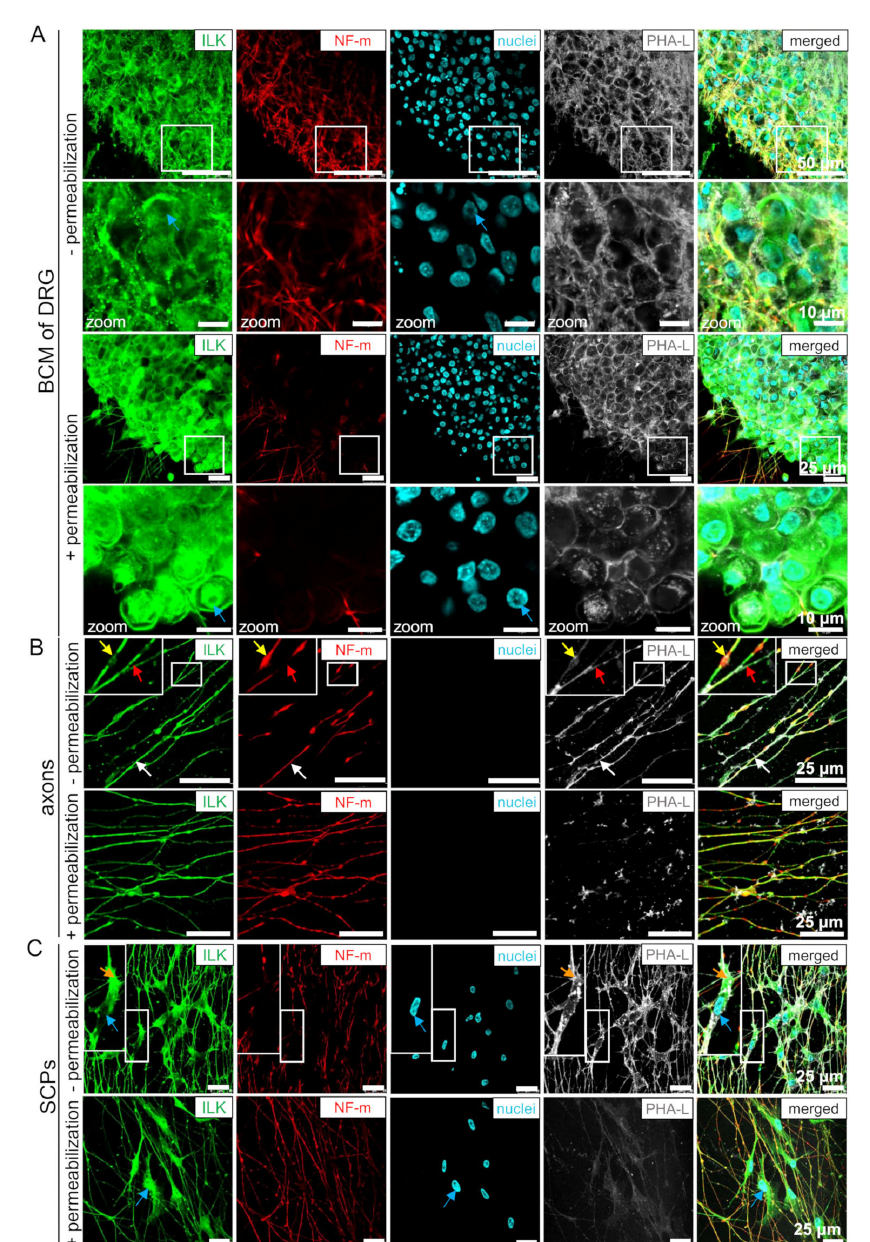
Figure 3. ILK is localized on the cell membrane of DRG neurons and SCPs. Localization of ILK on the cell membrane of DRG, which were cultured for 48 h on the surface coated with poly-D- lysine and additionally laminin-1. DRG explants were then stained and immunostained in the permeabilized and non-permeabilized conditions against ILK, NF-m, and Sox10. To detect the cell nucleus, the specimens were stained with Hoechst 33342. Lectin PHA-L conjugated with Alexa Fluor 488 was used for cell surface staining. A different pattern of PHA-L staining in permeabilized and non-permeabilized cells indicates the correctly performed immunostaining procedure. ( A ) The images show the localization of ILK on the surface of neuronal cell bodies (BCM). Blue arrows indicate cell nuclei; ( B ) The localization of ILK on the cell membrane of neurites. White arrows indicate the localization of ILK in neurites, yellow arrows point to the gaps in ILK-staining at the sites of neurofilaments accumulations, and the red arrows highlight neurofilament gaps in neurites; ( C ) Localization of ILK on the membrane of SCPs. Orange arrows indicate SCPs; blue arrows identify the cell nuclei. Enlarged images are shown in the insets or separate